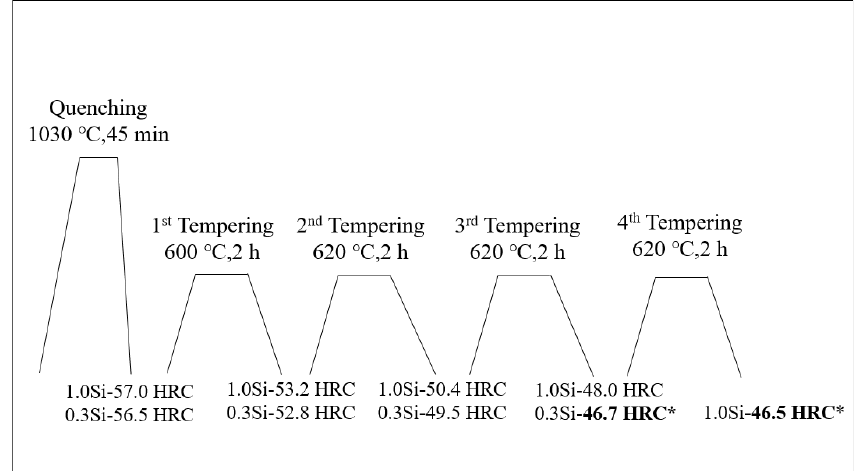
Figure 1. Heat treatment process curve of tested steel with modulated hardnesses of 46–47 HRC. (The hardness of 0.3Si steel reaches 46.7HRC after tempering for three times at 600 °C, 620 °C and hardness of 0.3 Si steel reaches 46.7 HRC after tempering for three times at 600 ◦ C, 620 ◦ C and 620 ◦ C 620 °C for two hours each time, and the hardness of 1.0Si steel reaches 46.5 HRC after tempering for two hours each time, and the hardness of 1.0 Si steel reaches 46.5 HRC after tempering for four for four times at 600 °C, 620 °C, 620 °C and 620 °C for two hours each time) times at 600 ◦ C, 620 ◦ C, 620 ◦ C and 620 ◦ C for two hours each